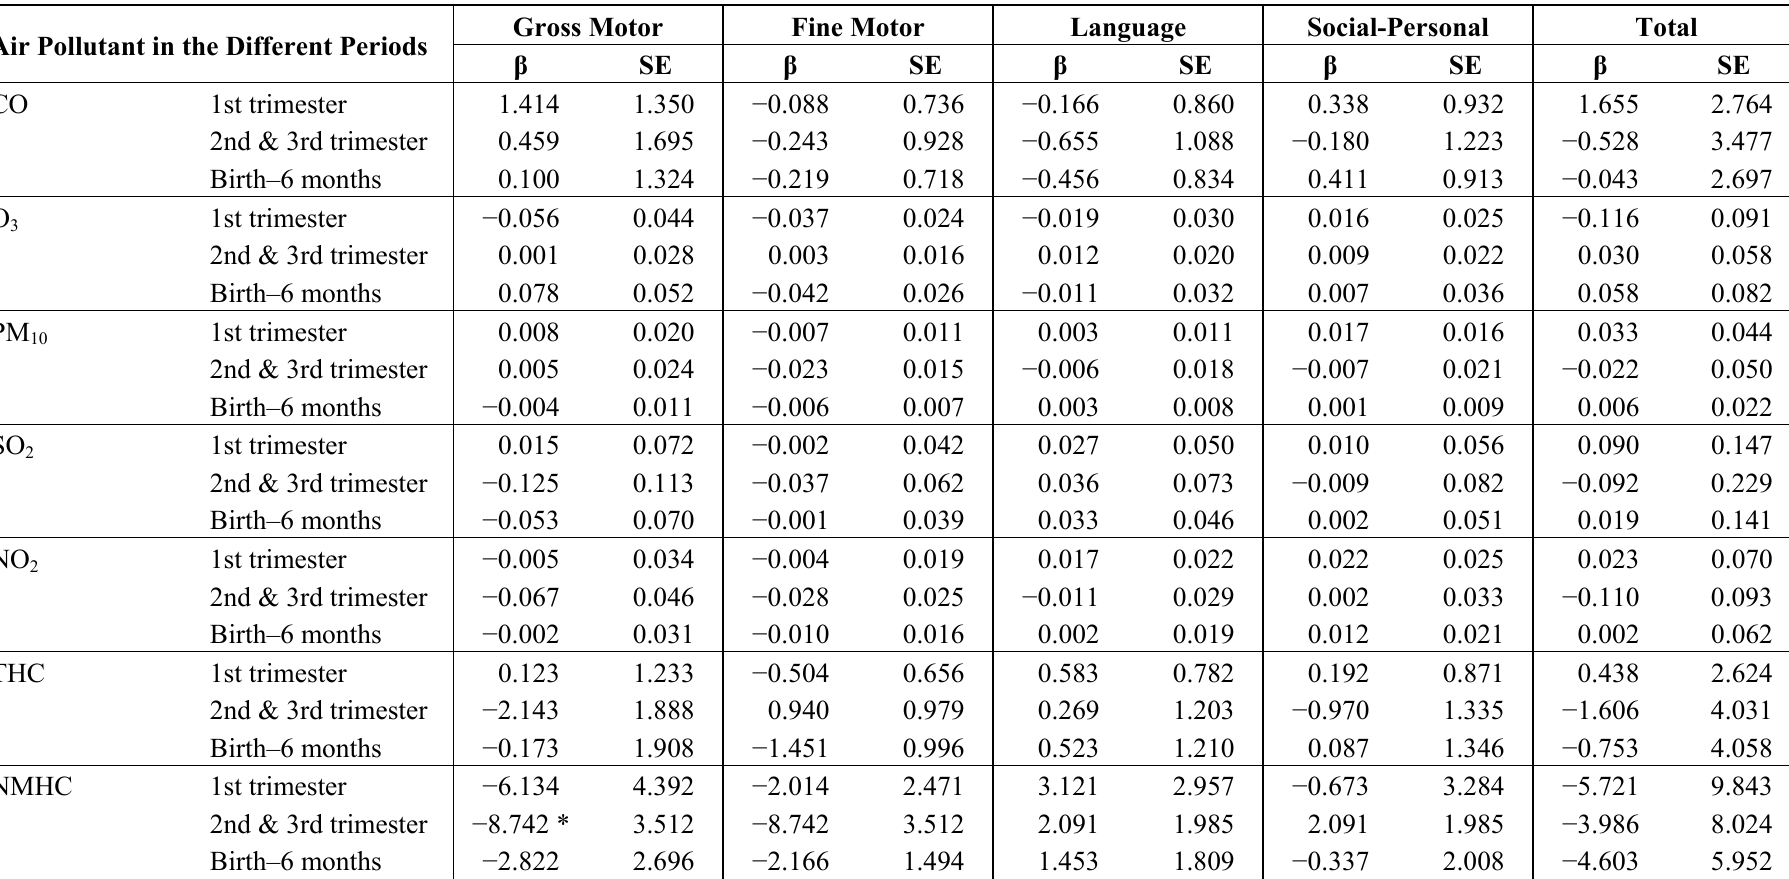
Table 3. Multilevel analysis of single air pollutants and neurodevelopment scores at six months of